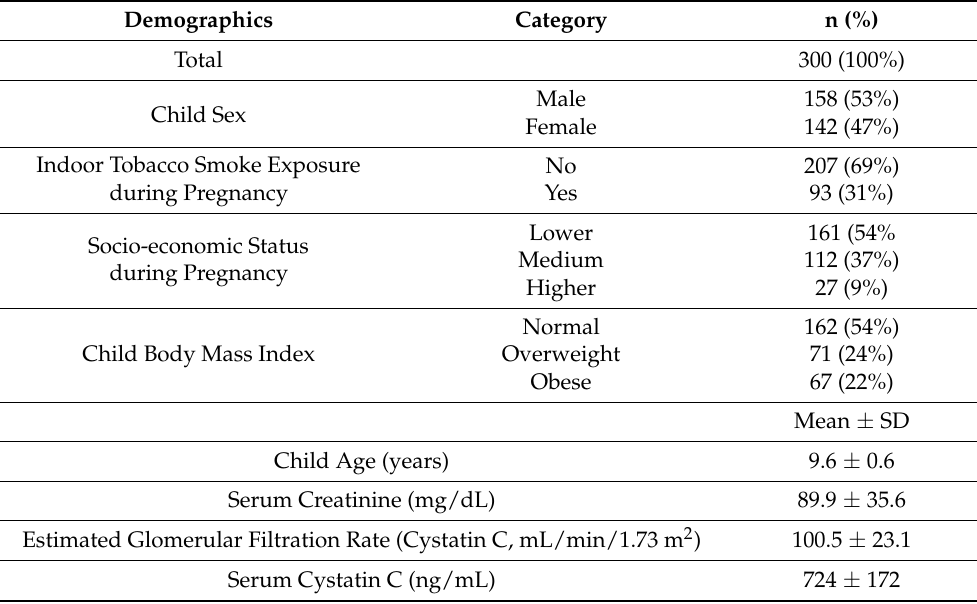
Table 1. Demographic information and descriptive statistics of the PROGRESS subjects in this study.